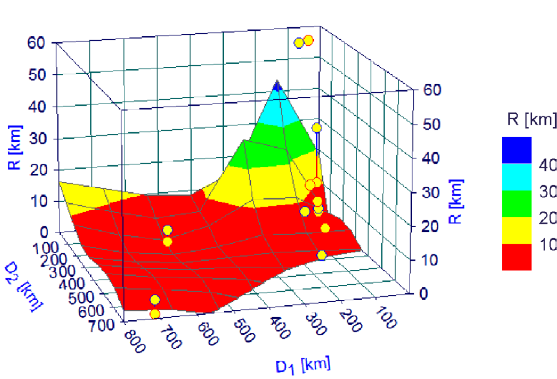
Fig. 2. Inter-dependence of the contractual ice drift D 1 and D 2 , and the resolution of the ice data sources R